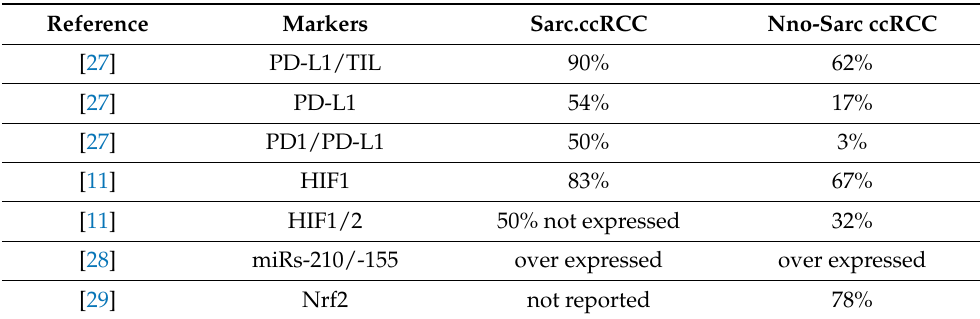
Table 1. Reported expression levels of biomarkers in ccRCC tumors with and without sarcomatoid differentiation.